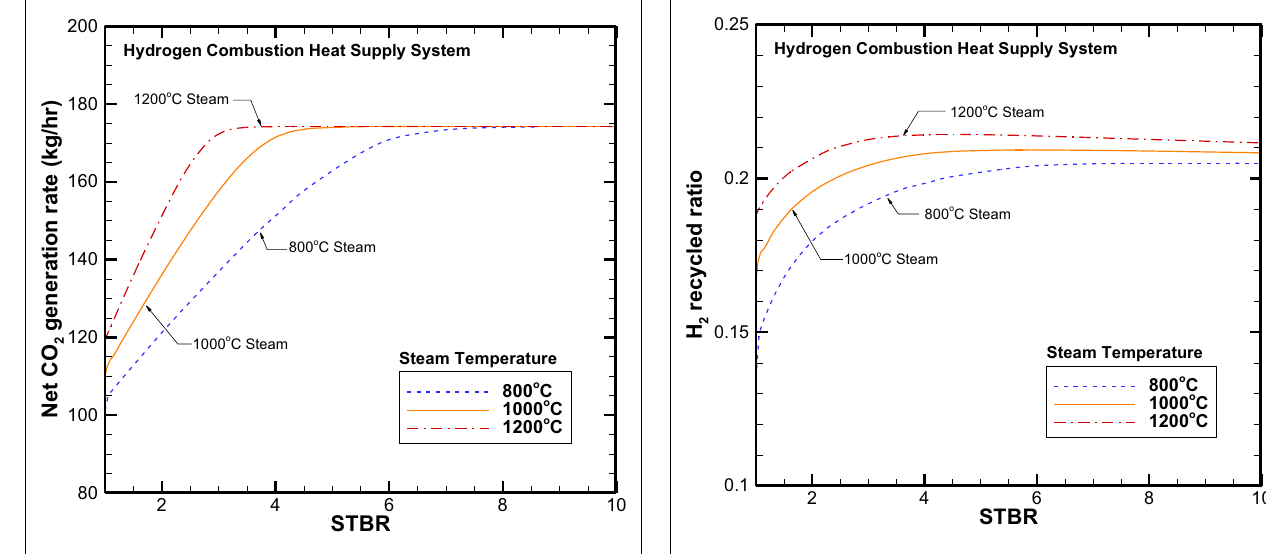
FIGURE 7 | Net carbon dioxide generation rate for concept system I as a function of STBR .